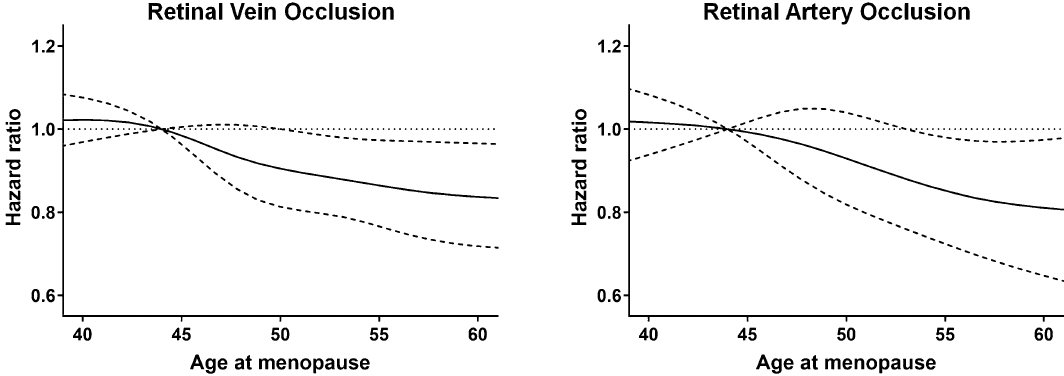
Figure 2. Restricted cubic spline curves presenting the adjusted hazard ratio for incident retinal vein occlusion and retinal artery occlusion according to age at menopause. Solid lines represent hazard ratio and dashed lines indicate 95% confidence interval based on restricted cubic splines for age at menopause with knots at the 5th, 35th, 65th, and 95th percentiles and reference point at the 5th percentiles of the distribution. The risk of retinal vein occlusion and retinal artery occlusion continuously decreased as age at menopause increased in Cox proportional hazard model fully adjusted for age, income level, systemic comorbidities, behavioral factors, and female reproductive factors (model